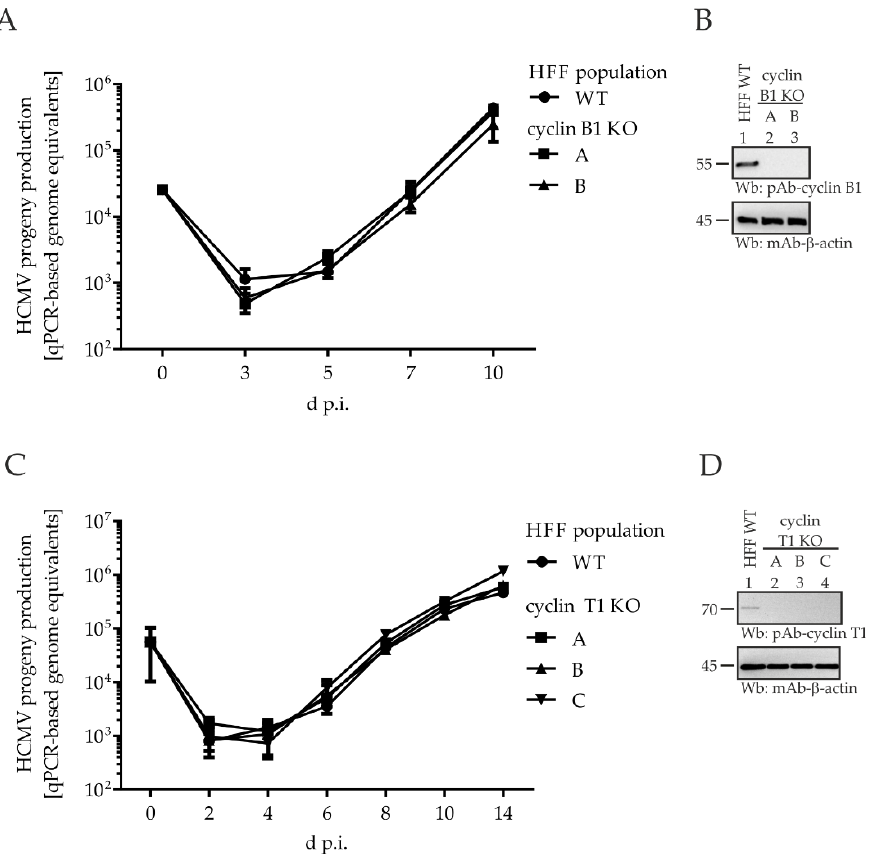
Figure 7. HCMV AD169-GFP replication kinetics in HFF WT and cyclin B1/T1 KO populations. HFFs were infected with HCMV AD169. Viral replication kinetics were determined by collecting viral supernatants at the indicated time points, and viral genome equivalents were determined by qPCR. Each value represents the mean ± SD of two independent biological replicates, each measured twice: ( A ) replication kinetics obtained for cyclin B1 KO cell populations A and B compared to WT (MOI 0.025); ( C ) replication kinetics obtained for cyclin T1 KO cell populations A, B and C compared to WT (MOI 0.01); ( B , D ) effectivity of cyclin B1 KO (cell populations A and B) and cyclin T1 KO (cell populations A, B and C), respectively, was verified by standard SDS-PAGE and Wb analysis using specific antibodies as